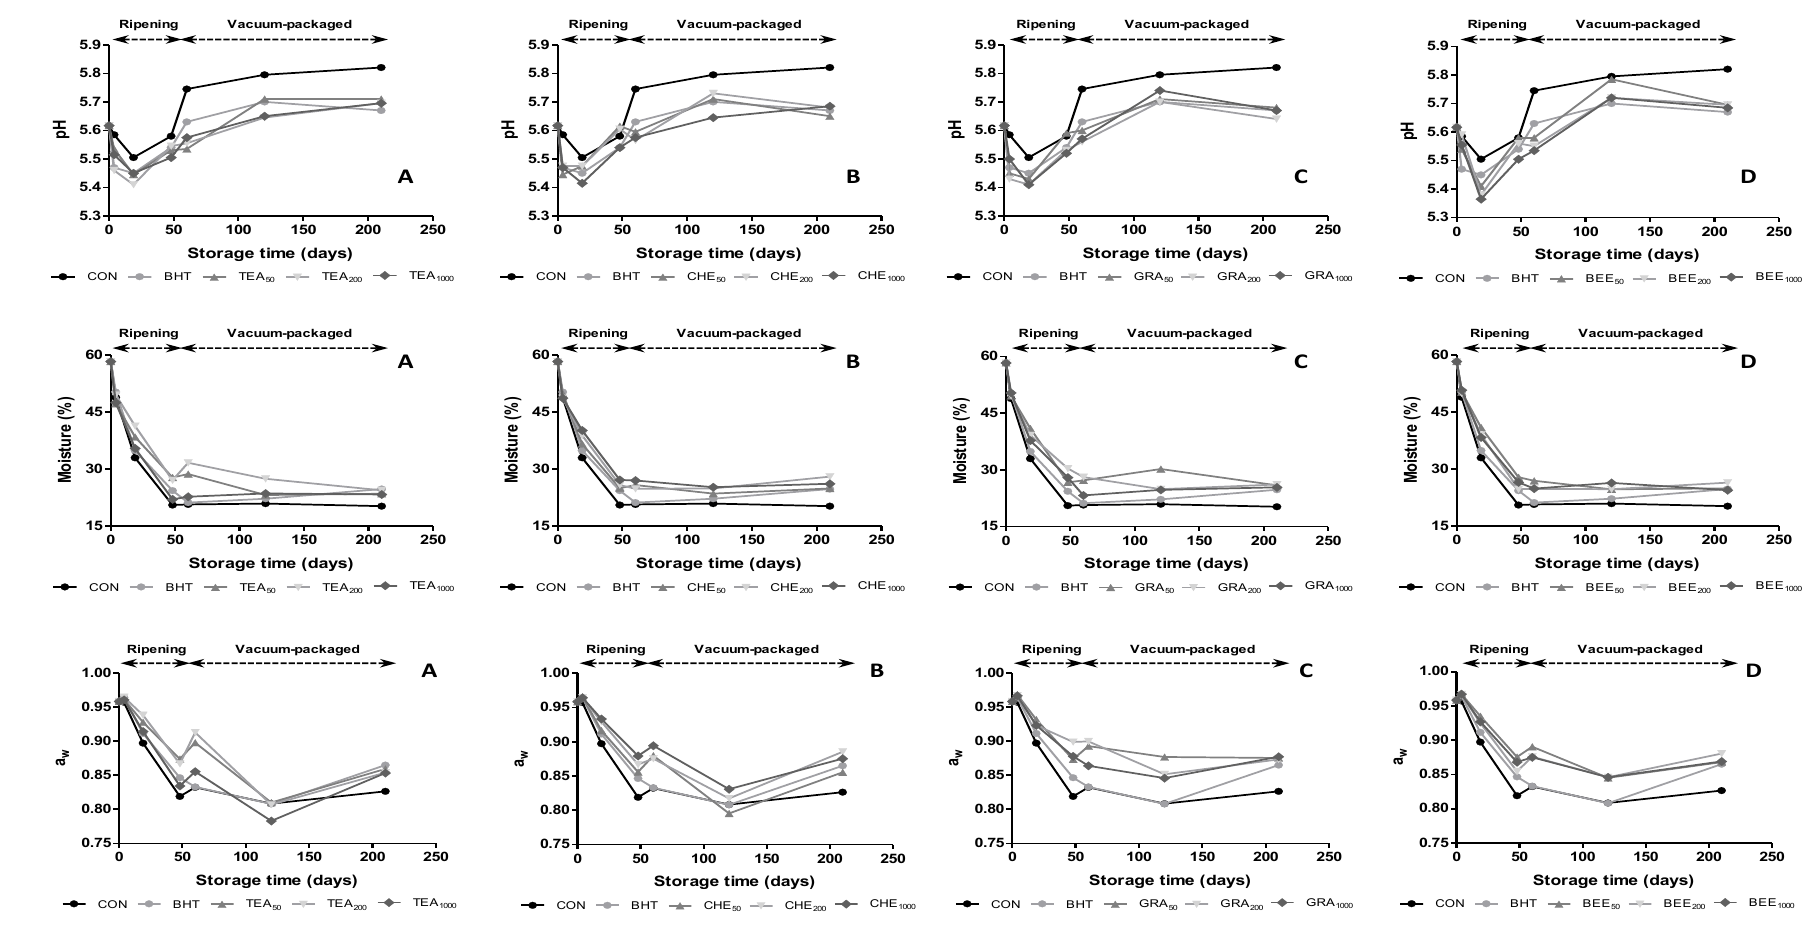
Figure 1. Evolution of pH values, moisture content and water activity in dry-cures sausages treated with butylated hydroxytoluene (BHT) and natural antioxidants during ripening and vacuum-packaged